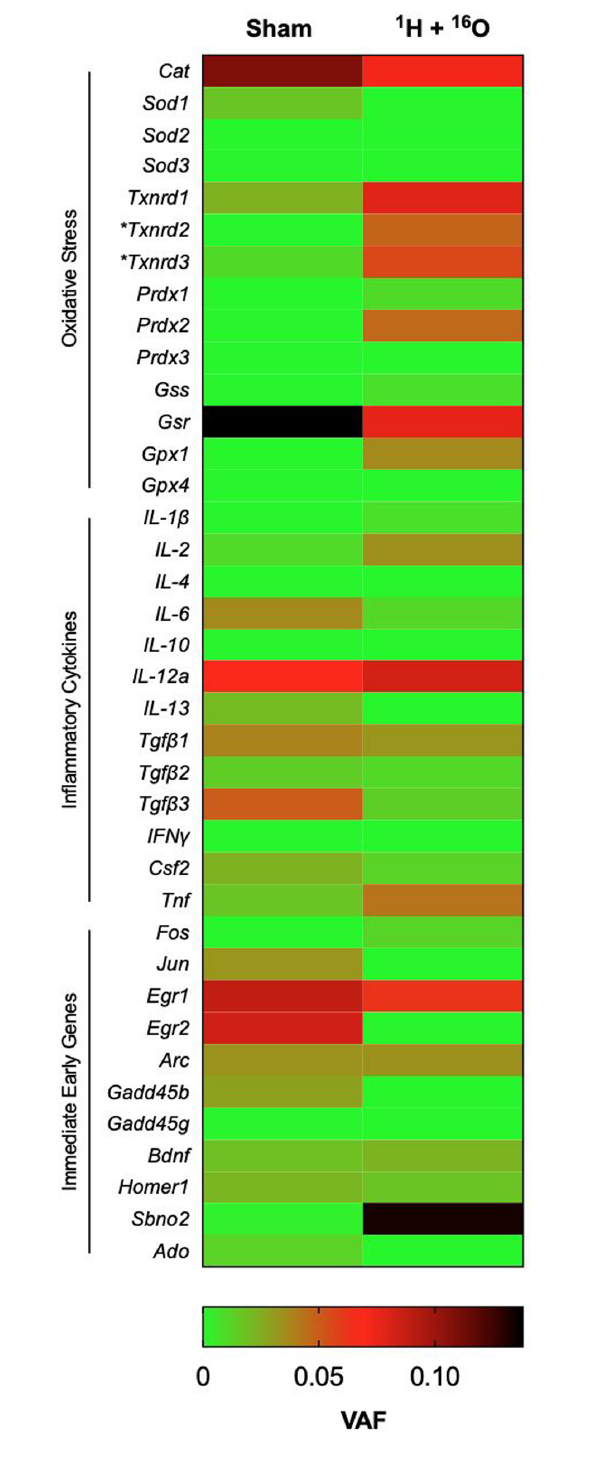
FIGURE 6 | Effects of 1 H + 16 O on SNPs in homogenous cell populations in the hippocampus. There were no significant effects of radiation on select genes for inflammatory cytokines, oxidative stress, and immediate early genes in the whole hippocampus. The only significant radiation-dependent increase in variant allele frequency occurred on oxidative stress elements Txnrd2 and Txnrd3 loci. Mean VAF ( n = 10); * P <